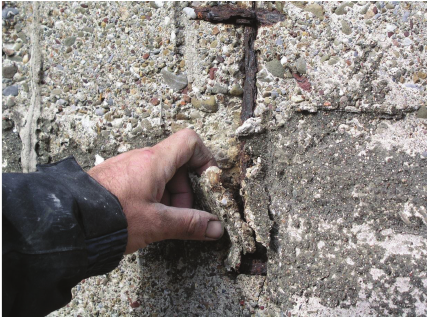
Figure 2: Ablation of concrete, before